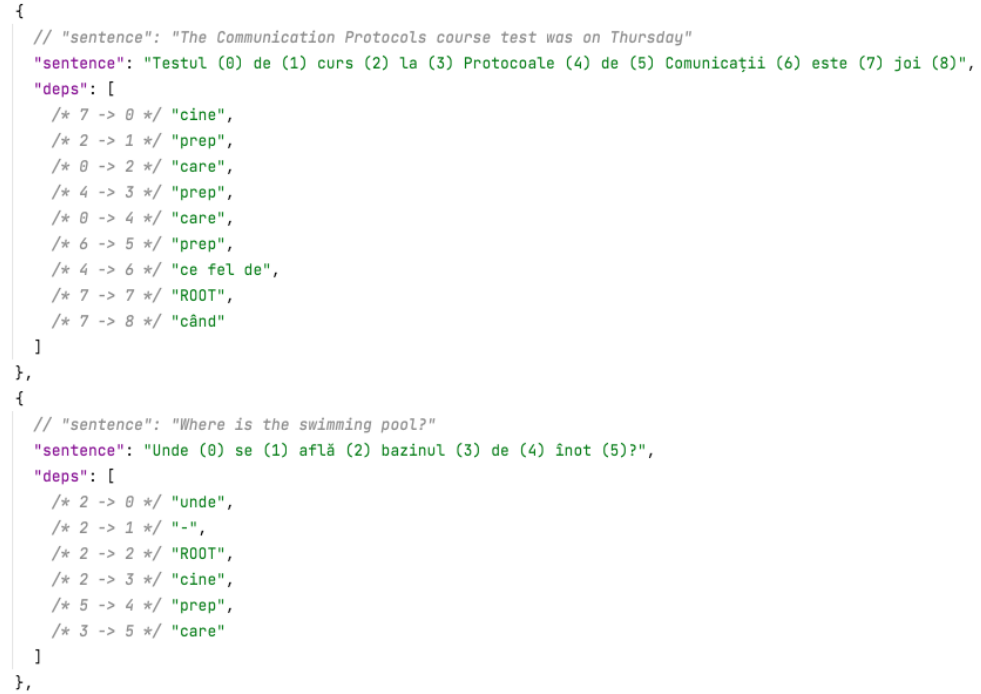
Figure 2. Syntactic parsing with annotated examples (token IDs are the corresponding numbers in